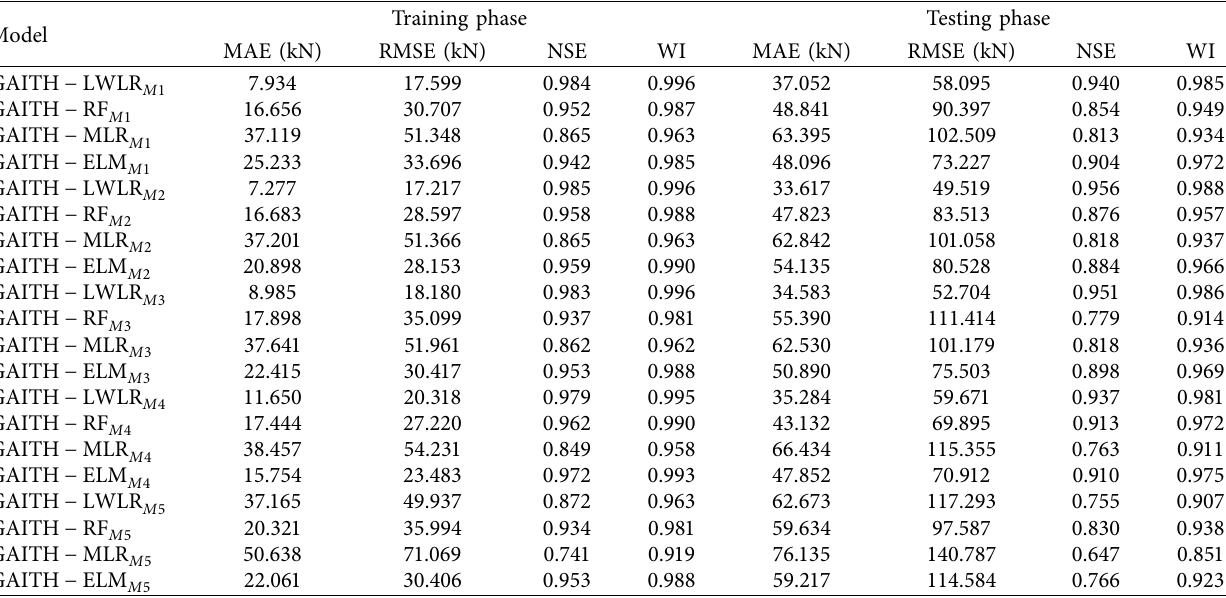
Table 7: The statistical description of the proposed models using GAITH.